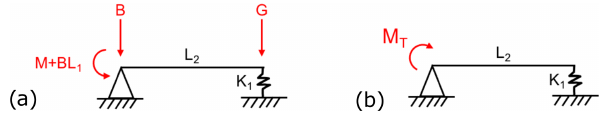
Figure 10. (a) Deflection model 1 (rotor weight and overturning moment). (b) Deflection model 2 (torsional-spring reaction force).